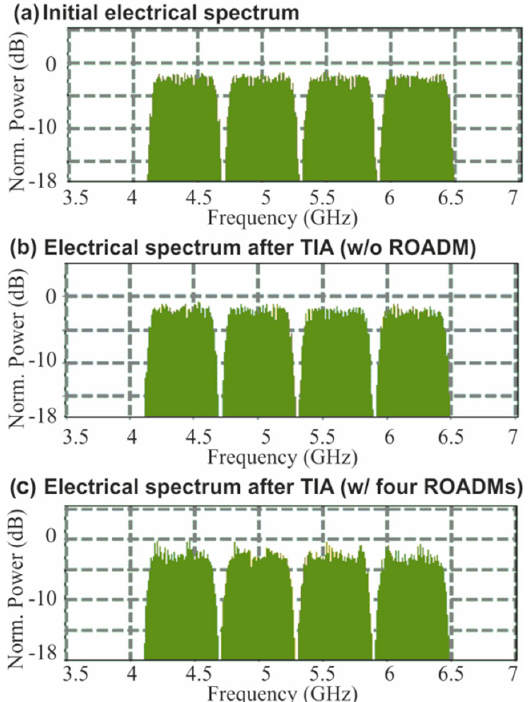
Figure 9. IF Spectra of ( a ) the OFDM 64-QAM signal inserted the EML , ( b ) o/e converted and amplified signal exiting the TIA for the reference link without any ROADM, and ( c ) the signal exiting the TIA for the hotspot link with the first three ROADMs in through mode and the ROADM4 in drop mode.